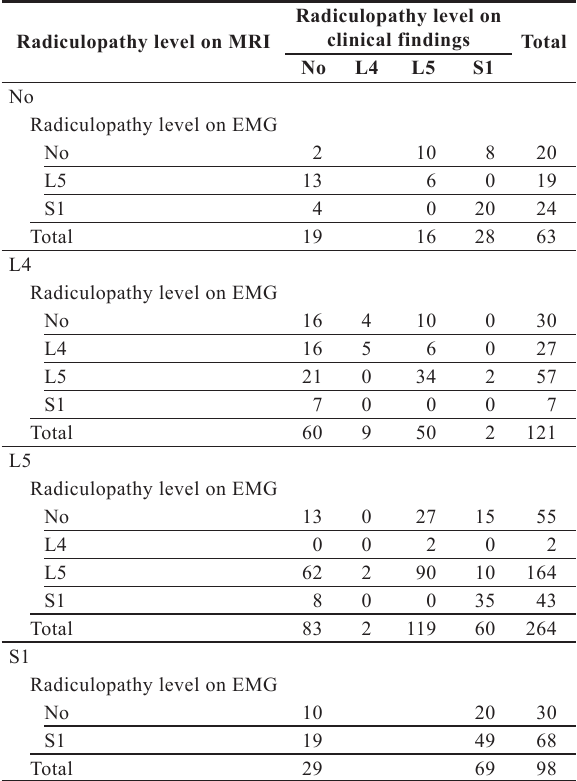
Table 4. The frequency distribution of radiculopathy level based on MRI, EMG and clinical findings.